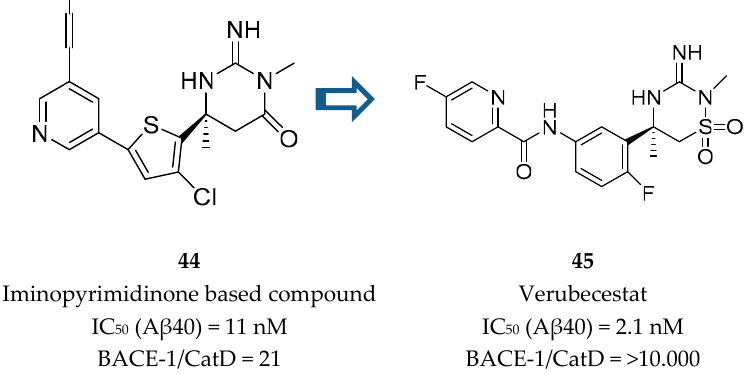
Figure 35. Structures of iminopyrimidinone based compound 44 and verubecestat ( 45 ).